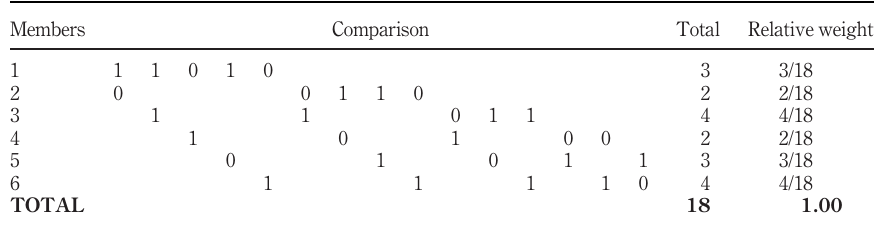
6. Foresight and Vision: Table 6 Paired comparison chart of each member on ‘ Foresight and Vision ’ .